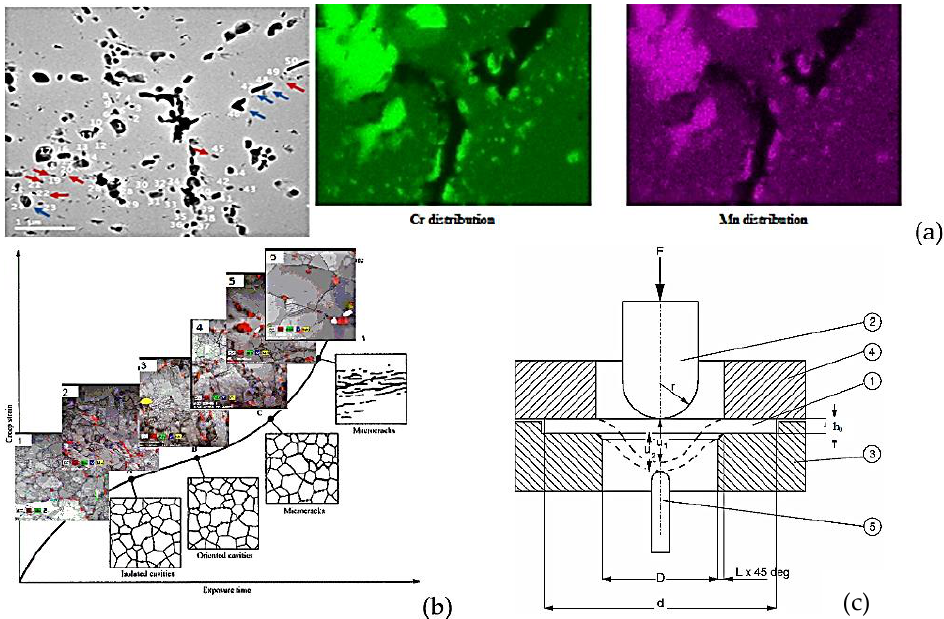
Figure 1. ( a ) Extraction replicas; ( b ) example of sketches representing the TEM examination of the martensitics, in the time/strain diagram used for the alloyed steels; and ( c ) an example of a small-scale test facility, which is a small punch creep testing machine.